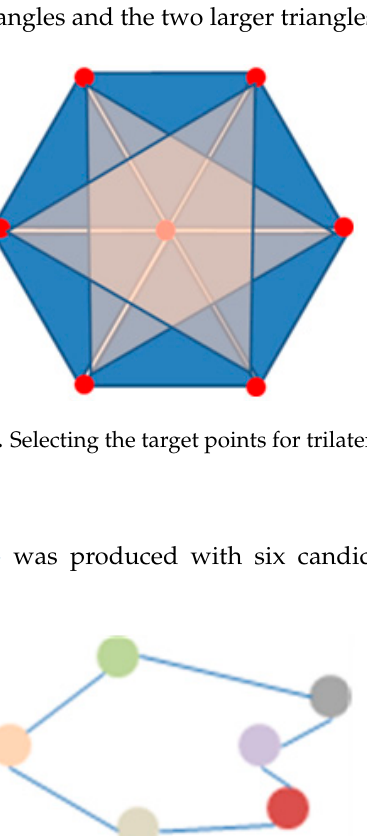
Figure 5. The COG of a Polygon.